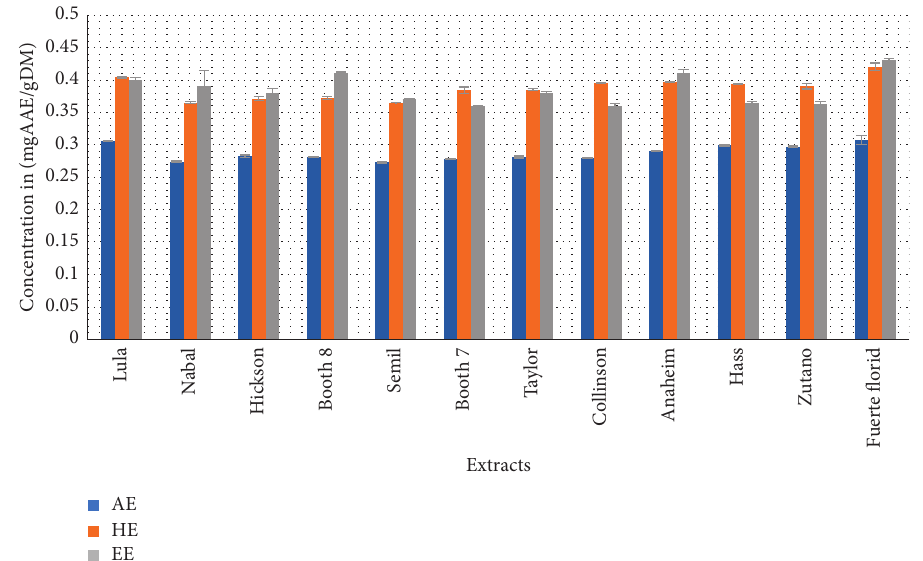
Figure 2: Iron reducing power (FRAP) of aqueous, hydroethanolic, and ethanolic extracts of Persea americana fruits peelings. Table 3: Correlation coefficients and P values between the bio- active compounds of different peelings extracts and different methods used to assess the antioxidant activity.